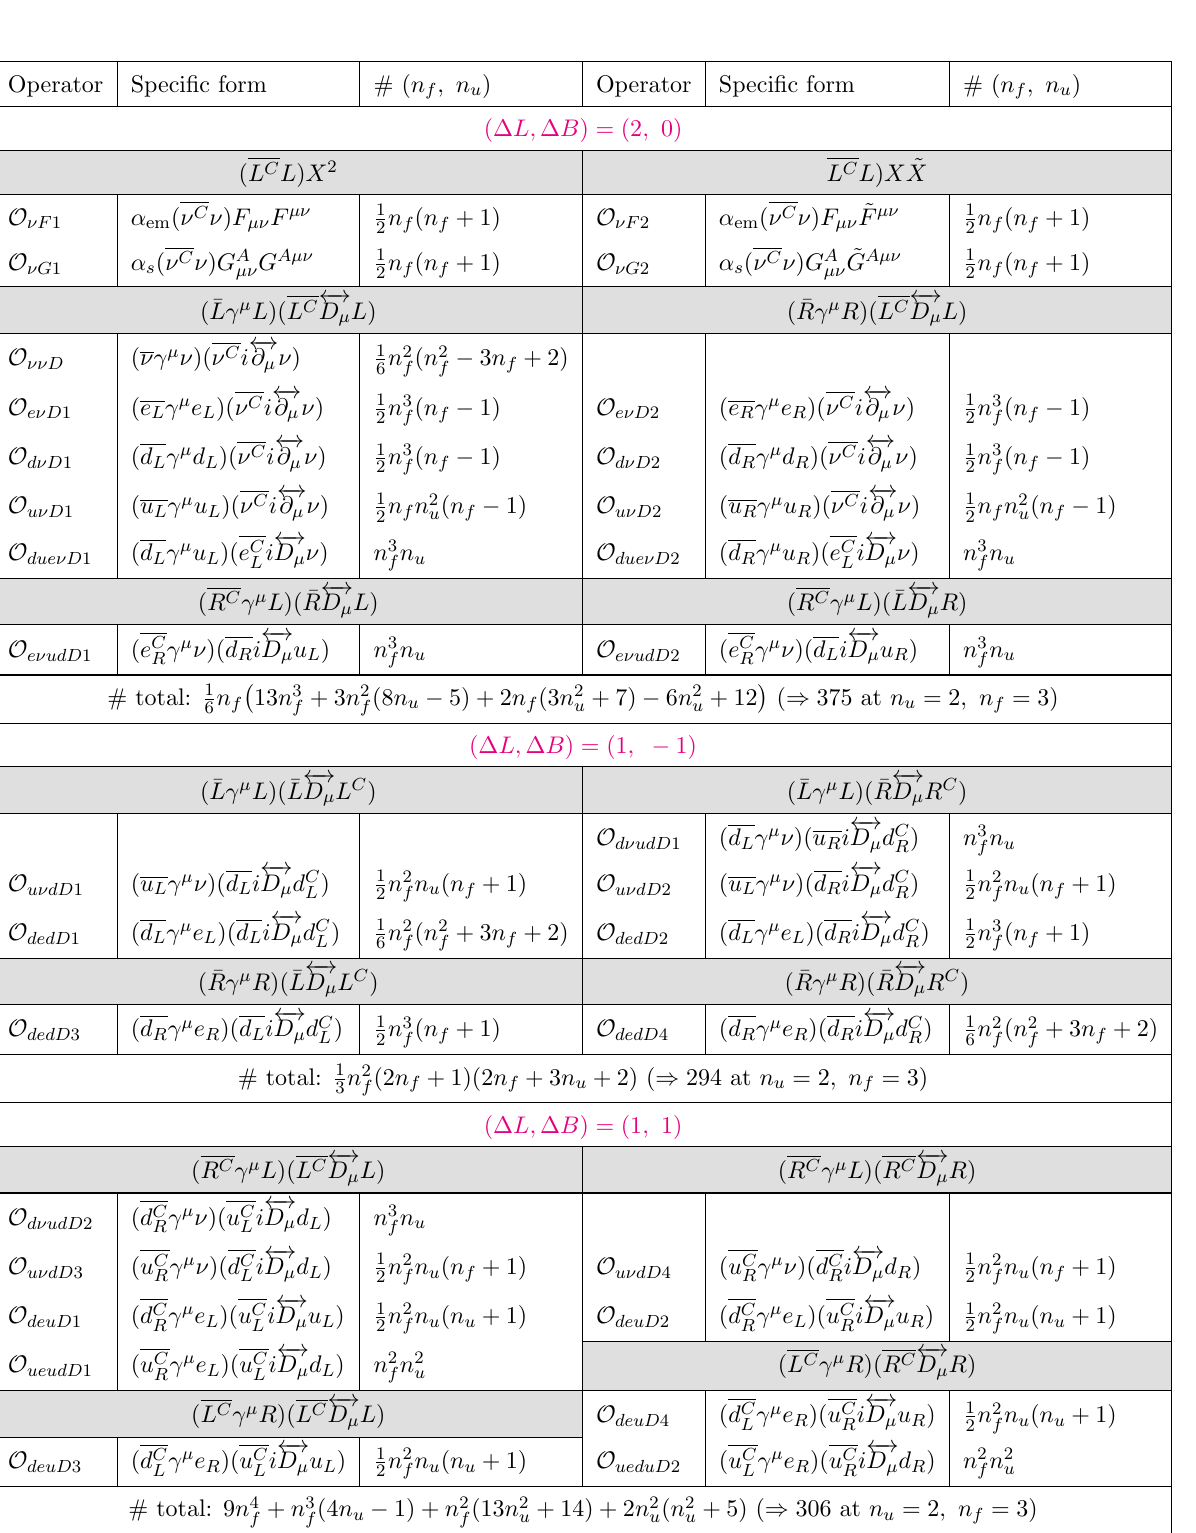
Table 2 . Basis of dim-7 operators in LEFT with lepton or baryon number or both violated, i.e., ((cid:1) B; (cid:1) L ) = (2 ; 0) ; (1 ; (cid:0) 1) ; (1 ; 1), together with count of operators for general n u ; n f . Color contraction is implied for triple quark (cid:12)elds, and ~ H = i(cid:27) 2 H (cid:3) and iD (cid:22) C (cid:17) ( iD (cid:22) ) C for brevity. Hermitian conjugate operators are not